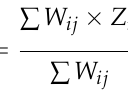
Figure 21. Rule design example from XSG.